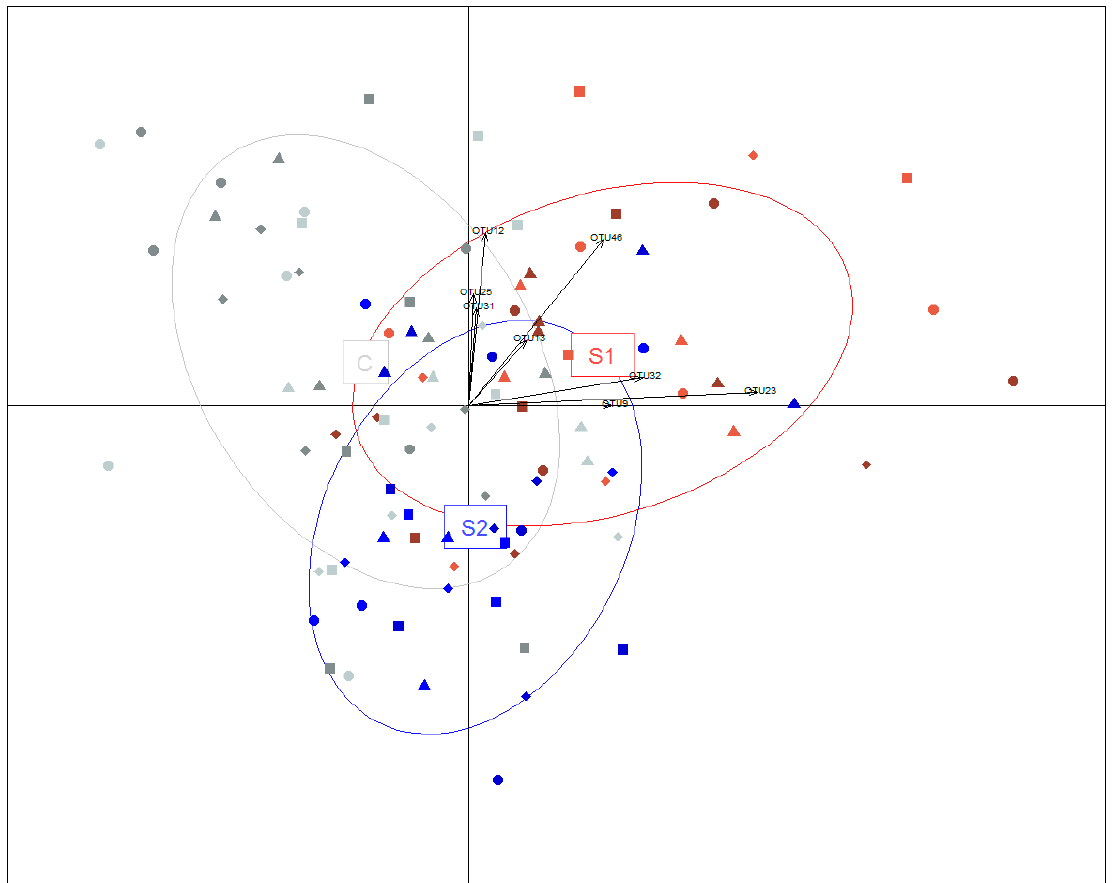
Figure 1. Multidimensional representation of the microbiota of piglets inoculated with either suspension S1, suspension S2 or the control piglets inoculated with saline water. The inset represents the variability taken into account by the principal component analysis (91%). The control piglets are in gray while the piglets force-fed with the S1 or S2 microbial suspensions prepared from the donor sows with low ARG levels are in red and blue. The contributions of the eight operational taxonomic units (OTUs) of interest are indicated by arrows. Piglets from sows 512, 709, 710 and 722 are represented as squares, circles, triangles and diamonds, respectively. The samples at 14 days are shown in lighter shades and the samples at weaning are shown in darker shades.